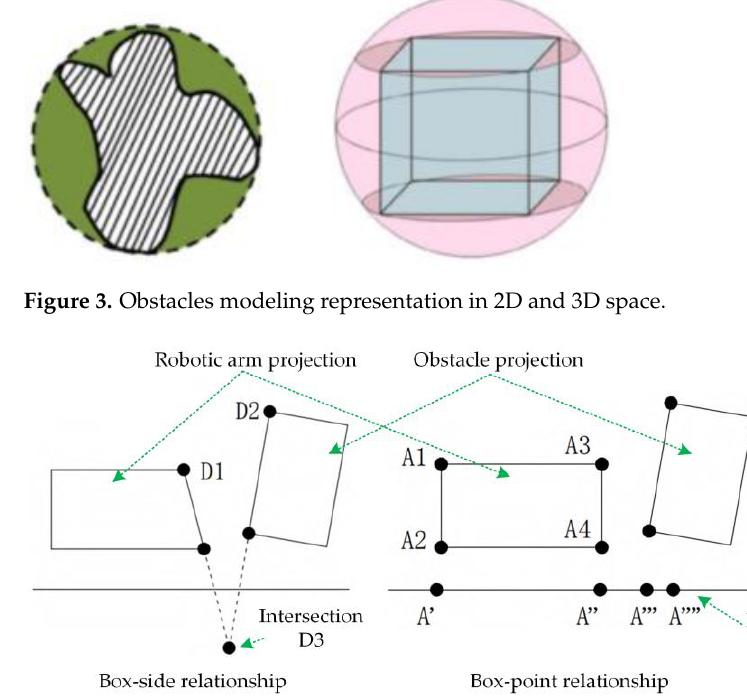
Figure 4. Projection of the robotic arm and obstacle.